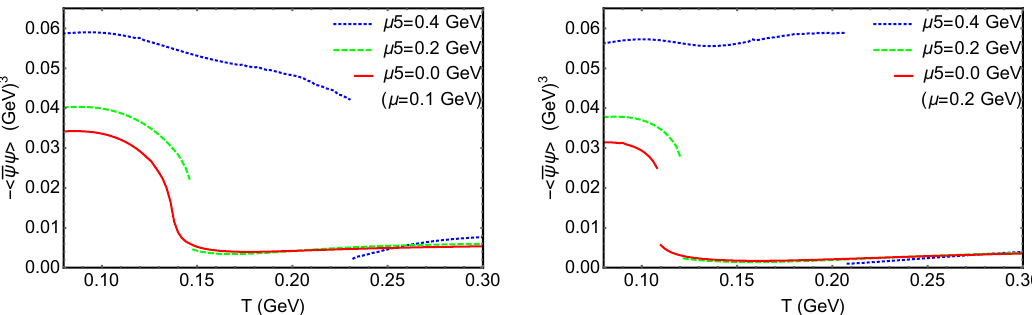
Figure 3 . The quark condensate from MT model at (cid:12)nite T with di(cid:11)erent (cid:22) ’s and (cid:22) 5 ’s.